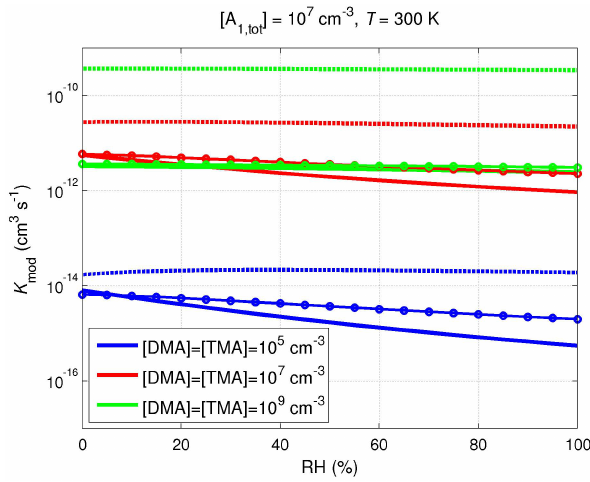
Fig. 6. The modelled coefficients K 22 as functions of relative hu- midity (RH). Solid lines correspond to K A2T2 , the dashed lines to K A2D2 and the solid lines with circles to K A2D1T1